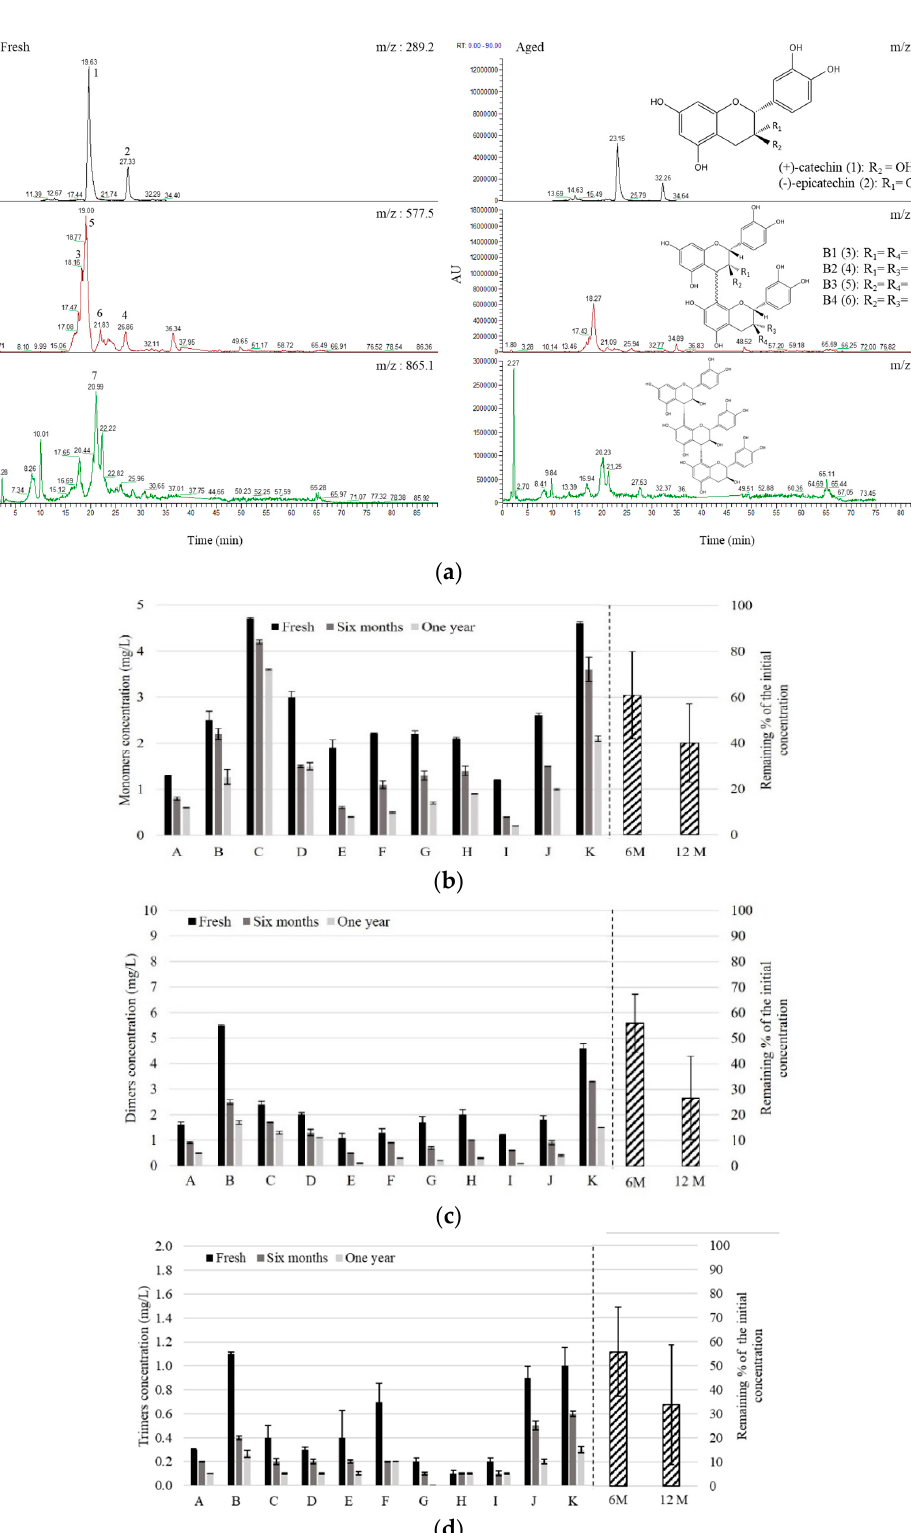
Figure 3. ( a ) Chemical structures of flavan-3-ols and RP-HPLC-ESI(-)-MS/MS chromatograms of fresh and one-year-aged beer K. 1: (+)-catechin, 2: (-)-epicatechin, 3: procyanidin B1, 4: procyanidin B2, 5: procyanidin B3, 6: procyanidin B4, and 7: procyanidin C2. ( b ) Monomers, ( c ) dimers, and ( d ) trimers concentrations (mg/L) in fresh, six-months-aged (6M), and one-year-aged (12M) NABLABs, measured by RP-HPLC-MS/MS and the respective remaining % of their initial concentration.